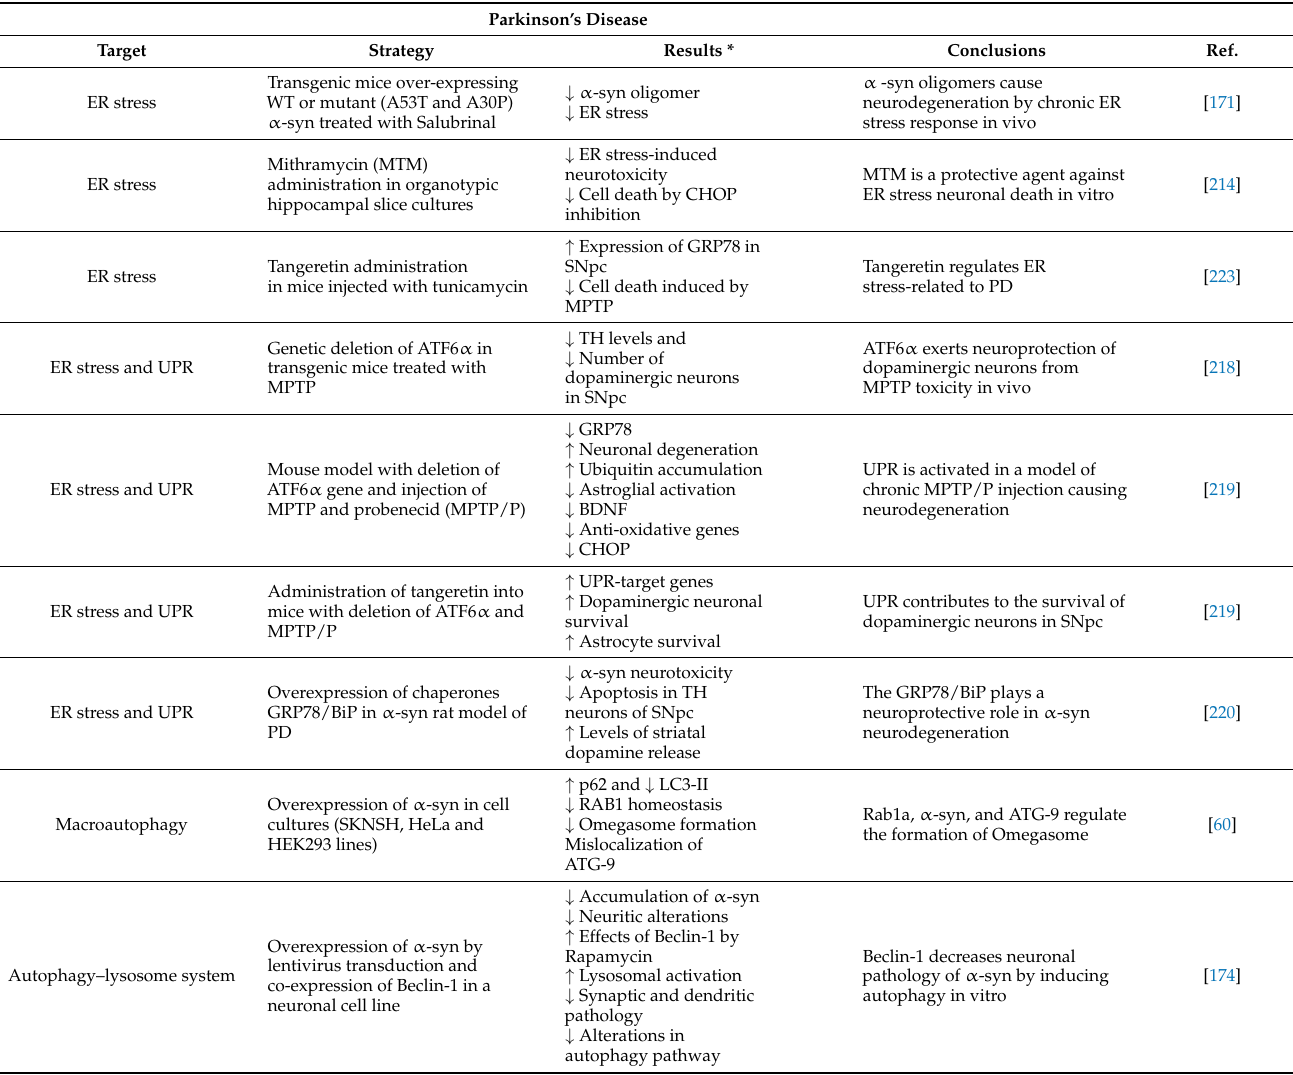
Table 2. Targets for clinical strategies against α -syn neurotoxicity in